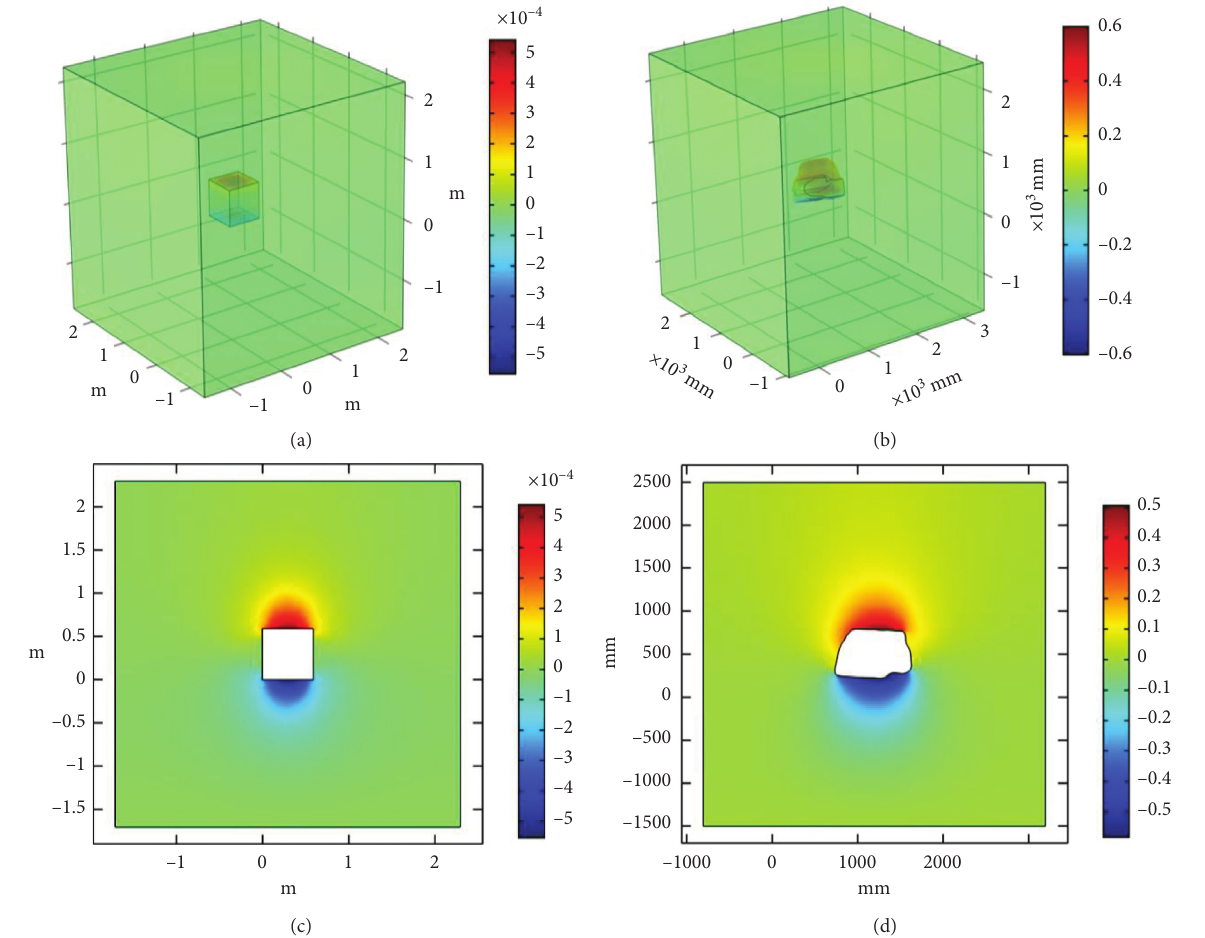
Figure 15: Vertical displacement field of (a) 3D profile using cube model; (b) 3D profile using the cube-like model; (c) 2D profile using cube model; and (d) 2D profile using the cube-like